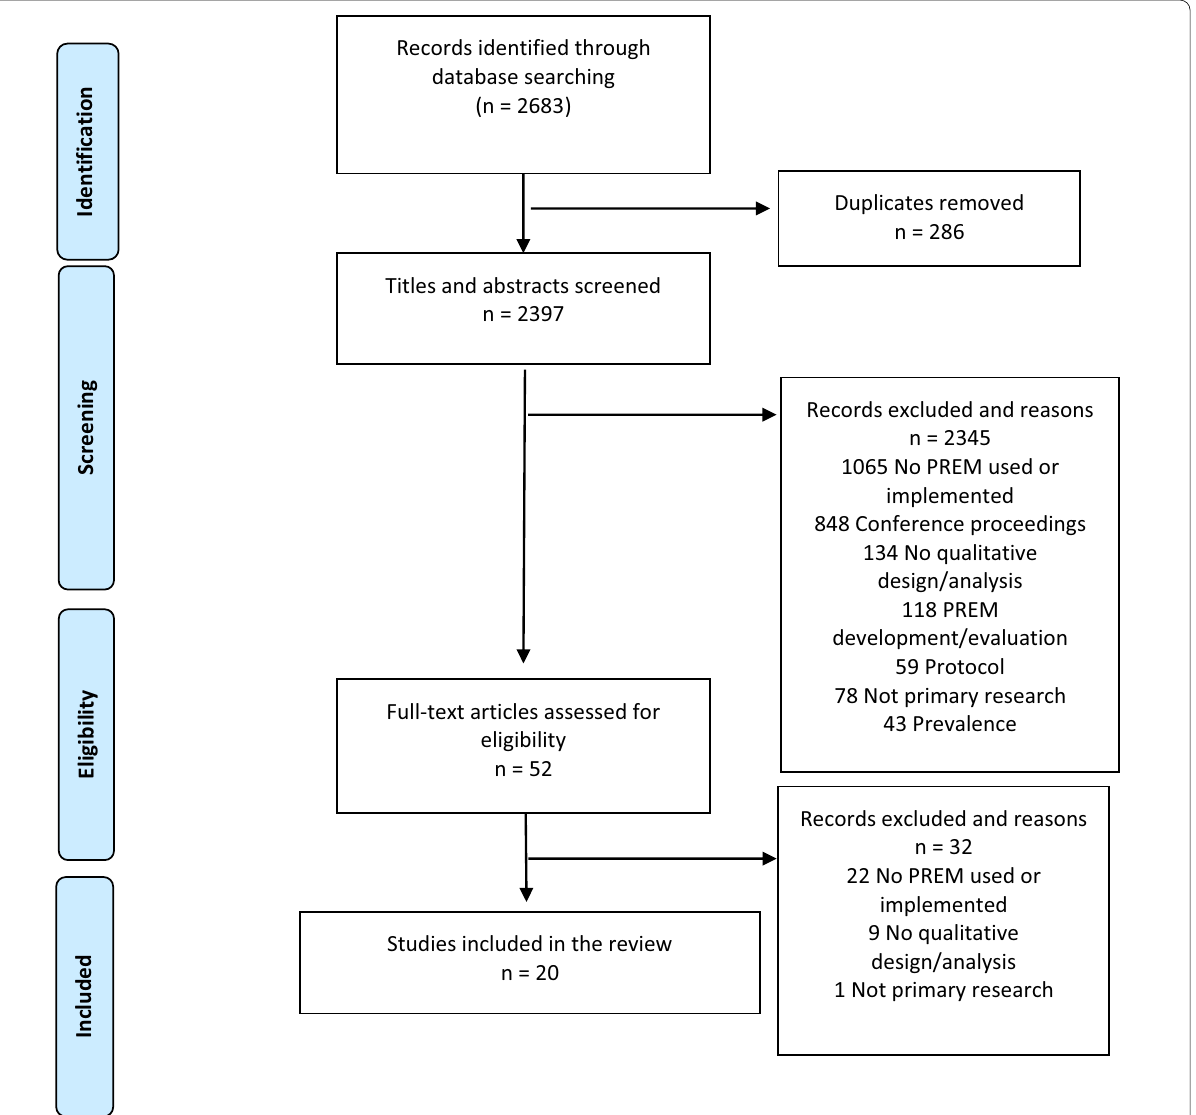
Fig. 1 Prisma flow diagram describing study inclusion for the